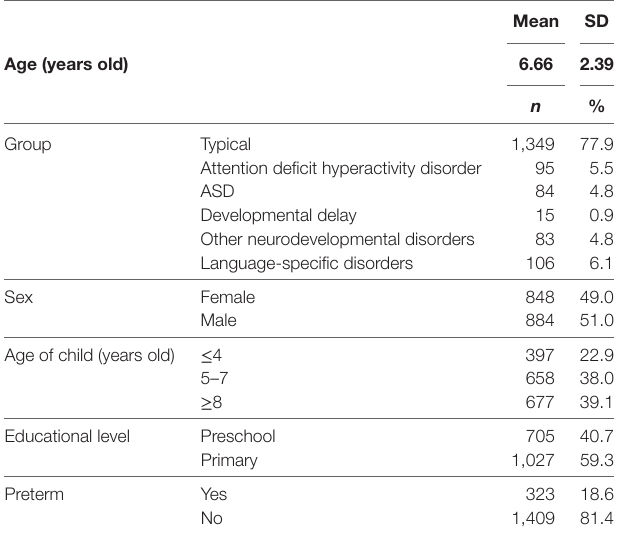
tAble 1 | Description of the sample ( n =